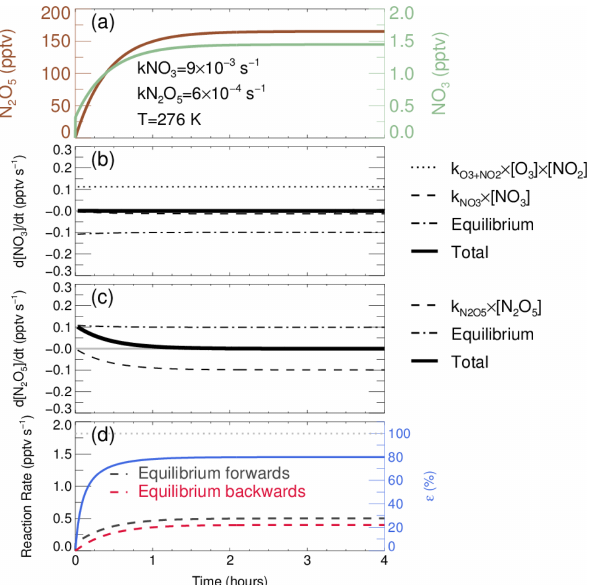
Figure 1. Evolution of the NO 3 –N 2 O 5 system simulated by the steady-state model for an average case. (a) Temporal profiles of N 2 O 5 and NO 3 ; the constraint of simulation is displayed as the text. (b) Evolution of d[NO 3 ] / d t calculated from the source of ×[ O ]×[ NO ] , sink of kNO × [NO k O 3 2 3 3 ], and equilibrium 3 + NO 2 terms, detailed in the text. (c) Evolution of d[N 2 O 5 ] / d t calculated from equilibrium terms, sink of kN 2 O 5 × [N 2 O 5 ]. (d) Forward (N 2 O 5 formation) and backward (N 2 O 5 decomposition) equilib- rium rates are represented as black and red dashed lines, and the equilibrium completeness ε is calculated by the ratio of backward rate over forward rate, shown as blue full